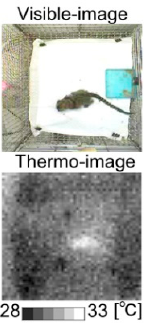
Figure 1. Example of common marmoset visible and thermal image.